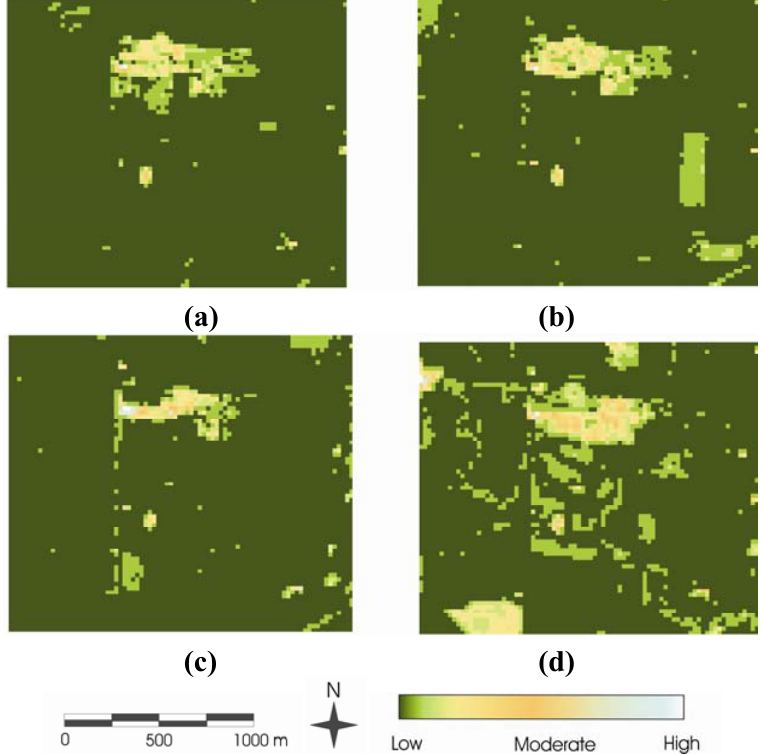
Figure 8. Characterization of surface vegetation anomaly patterns; (a) 23 August 2007